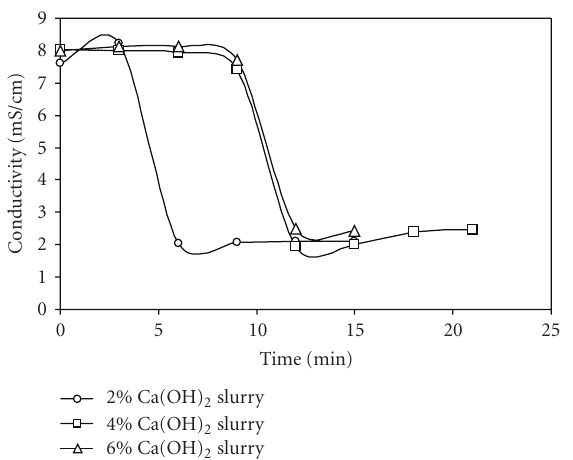
Figure 9: E ff ect of Ca(OH) 2 slurry concentration onto the conductivity at 5 l/min CO 2 gas flow